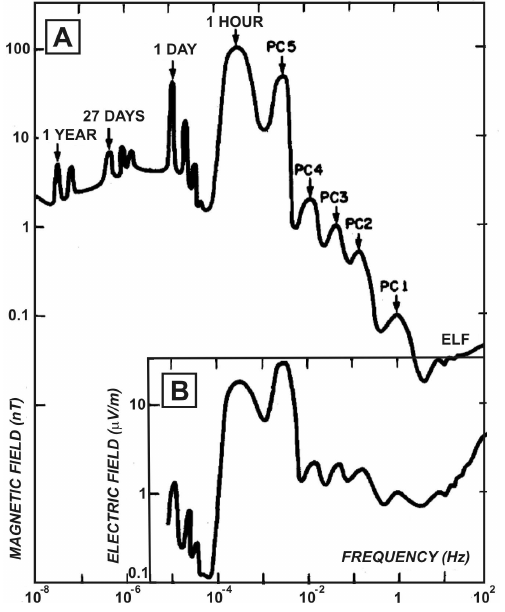
Figure 1. Natural variations of the electric and magnetic fields (from Serson, 1973).